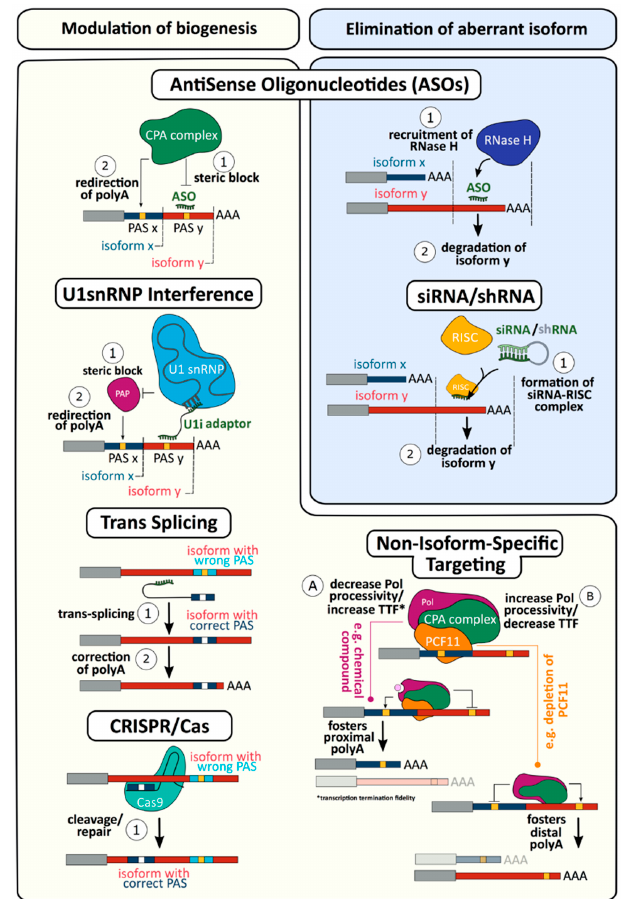
Figure 5. CPA/APA and therapy. Different approaches and mechanisms to correct deregulated APA through modulation of biogenesis and/or elimination of faulty isoforms . Antisense Oligonucleotides (ASOs): A designed sequence of oligonucleotides anneals a target region, leading alternatively to the steric block of the CPA complex or recruitment of RNAseH and subsequent degradation. The choice of one mechanism over the other depends on the generation of nucleotides used. U1snRNP interference: A bifunctional U1 adaptor is designed to anneal simultaneously to the 5’ end of U1snRNP and to the target sequence. The steric block induced by the complex redirects PAP to a different PAS. Trans Splicing: The therapeutic agent comprises a binding domain complementary to the target pre-mRNA, an unpaired oligonucleotide spacer and a coding domain containing the sequences to be trans-spliced into the target. This structure enhances specific trans-splicing of the target pre-mRNA, which competes with the cellular cis-splicing (which would bring the “pathological” mRNA) by creating a chimeric RNA molecule. The exogenous sequence carried by the structure is subsequently incorporated in the mature transcript, downstream enabling the biosynthesis of a significant amount of the corrected protein. CRISPR/Cas9: By means of Cas9 enzyme, the isoform containing the wrong PAS can be edited, inserting a new sequence containing the correct PAS. siRNA / shRNA : The administered siRNA / shRNA, after being processed in the nucleus, is loaded on RISC. The nucleotide strand directs RISC to the target mRNA leading to degradation or silencing of the complex. Non-isoform-specific targeting : The choice of one isoform over the other can be fostered, interfering with the CPA machinery. (A) Administration of chemical compounds targeting PolII can decrease processivity of the enzyme and increase transcription termination fidelity. Contrary to that, (B) depletion of specific components of the machinery (e.g., PCF11) leads to an opposite result. Interference based on “component-targeting” rather than “isoform-targeting” reflects into widespread changes eliciting possible side e ff